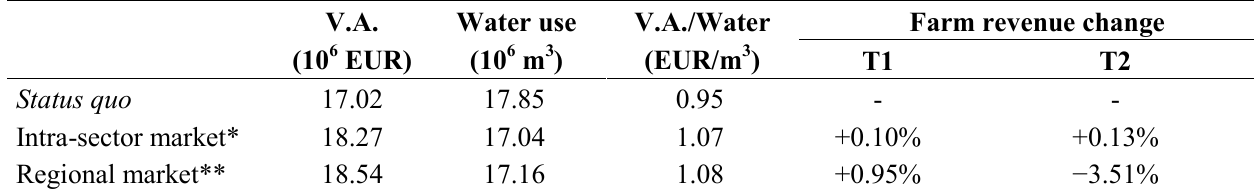
Table 7. Overall effects of legislative framework change at basin